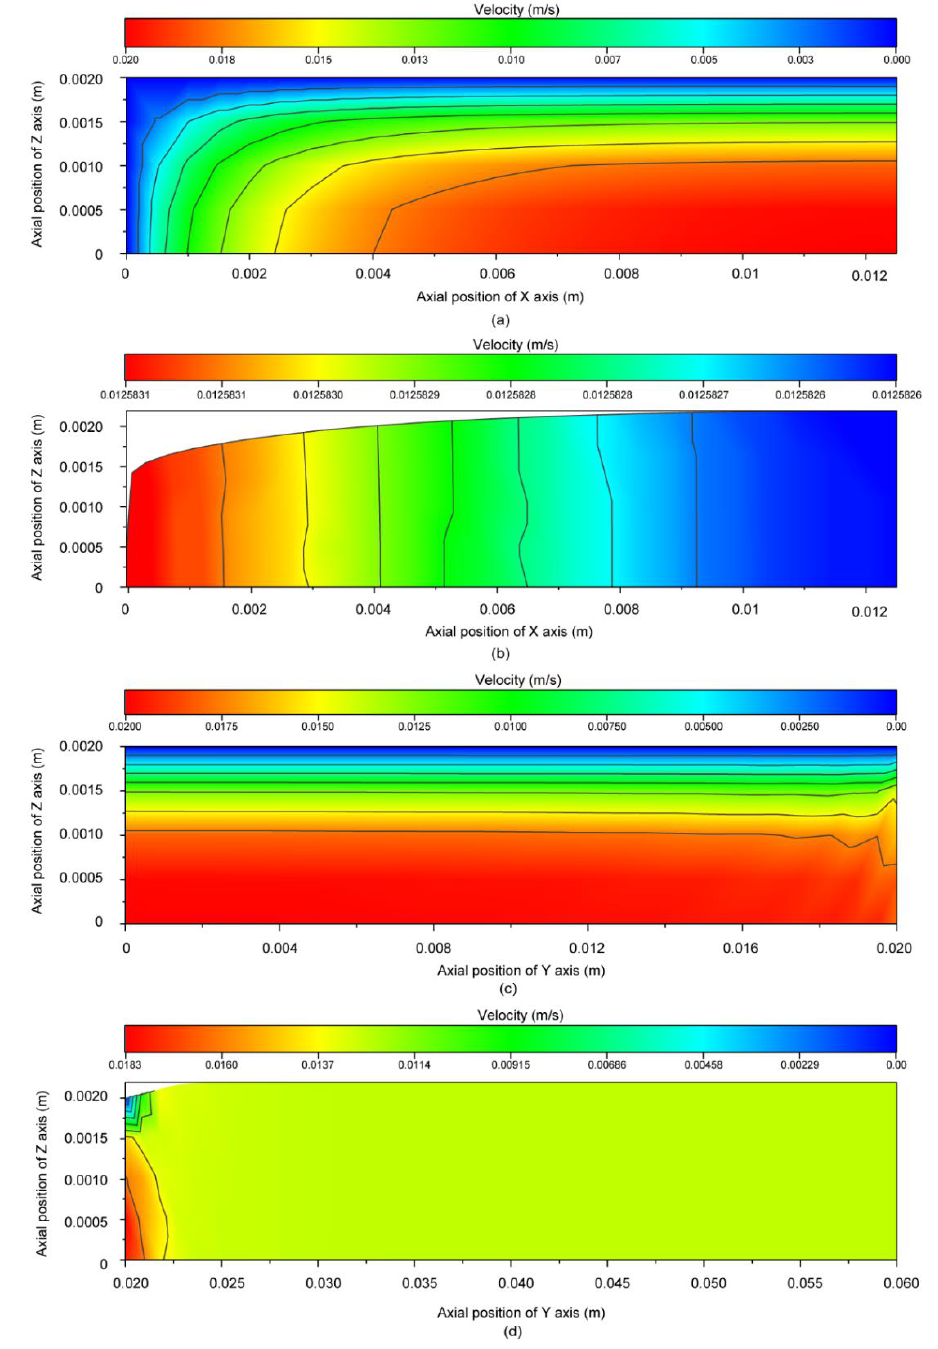
Figure 4. The velocity field distribution of the WPC with 40% wood fiber as an example. Distribution of velocity at: ( a ) the inlet; ( b ) the outlet; ( c ) on the plane of symmetry 1; ( d ) on the plane of symmetry